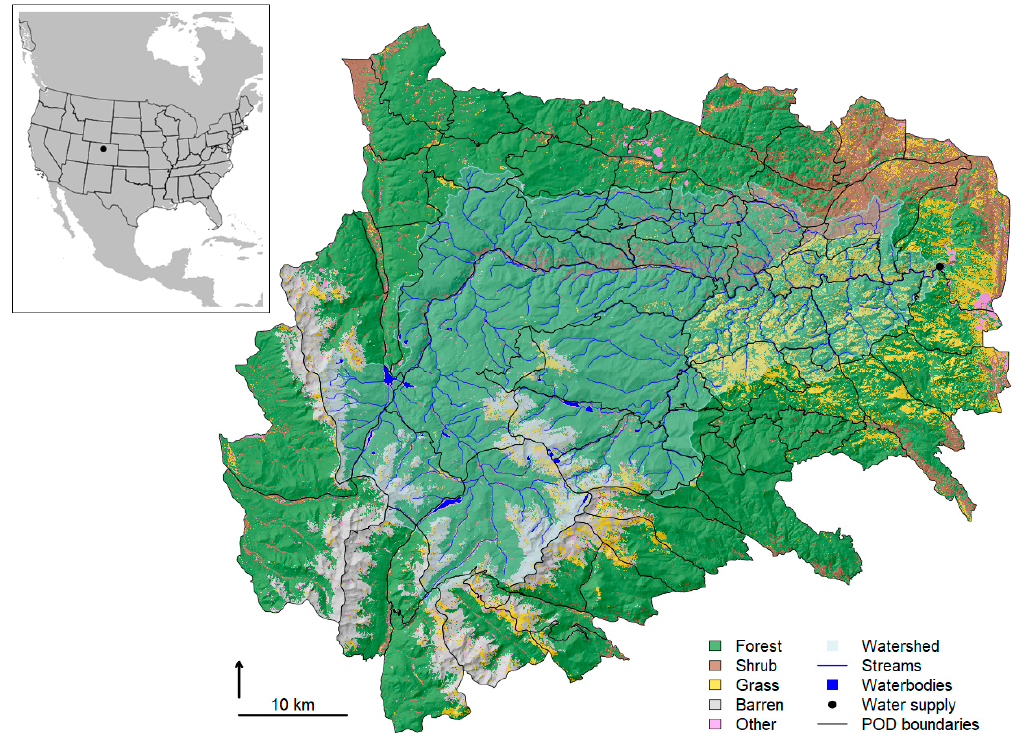
Figure 2. Map of the study area featuring the focal watershed and PODs that intersect a five km buffer around the watershed. Landcover is from LANDFIRE [50]. Barren is sparsely vegetated alpine. The inset maps the location of the study area in the USA.